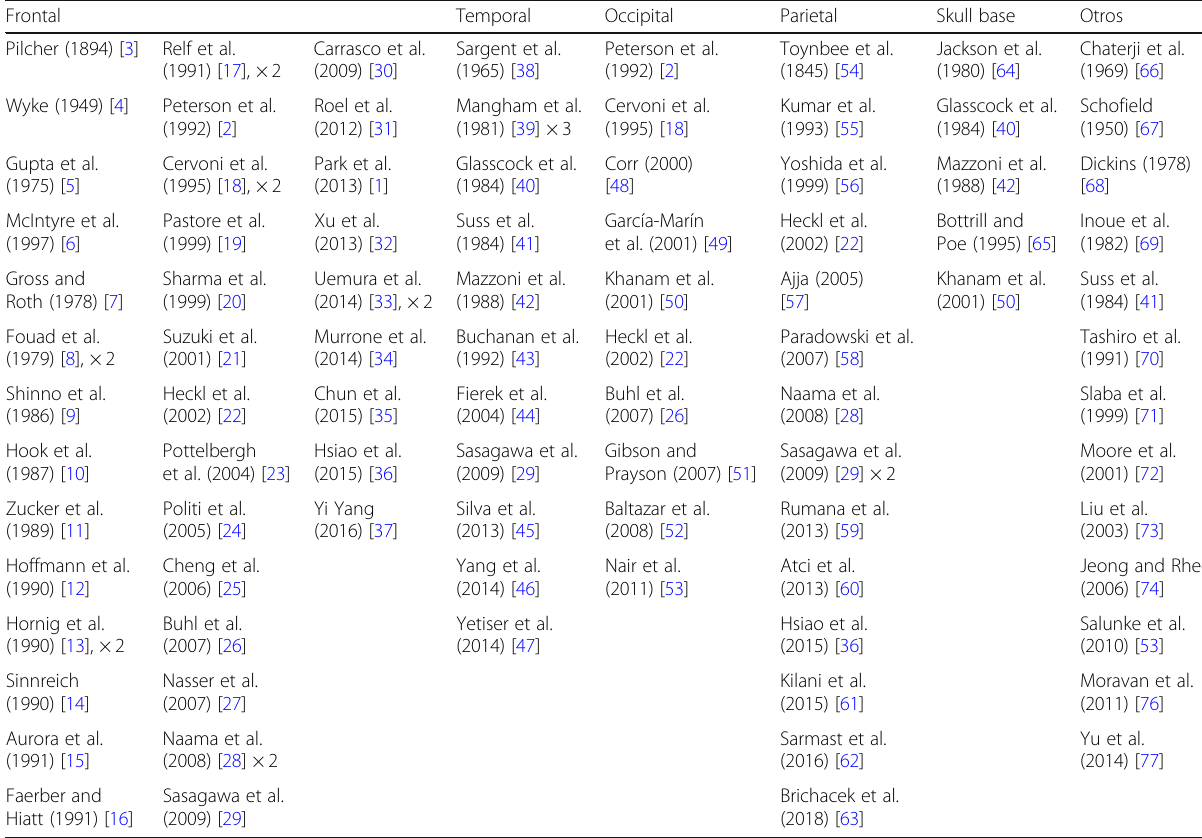
Table 1 Review of the literature from 1845 to 2016 of the published cases of intraosseous hemangiomas